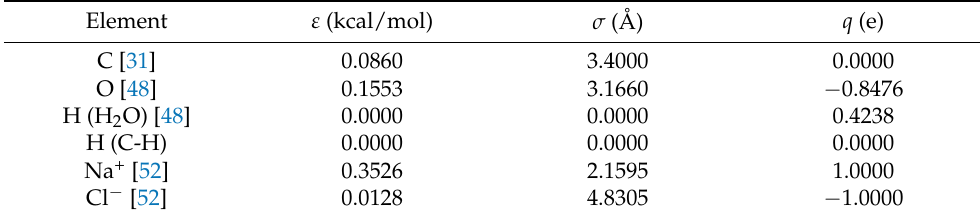
Table 2. Parameters in the potential functions for describing the nonbonding